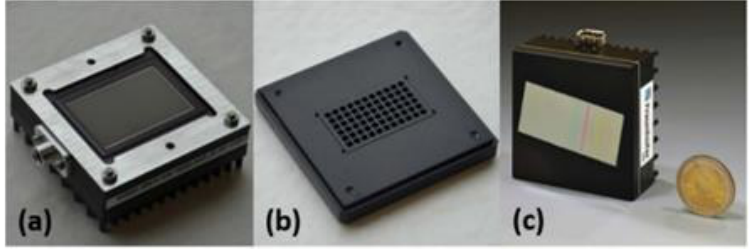
Figure 34. ( a ) Front view of the MSI concept based on a multi-aperture system approach with a slanted LVF. ( b ) Spectral sampling for tilted (red) and non-tilted (blue) orientations of the LVF. The image sensor was a KAI-16000 full-frame CCD, the target surface size was 24 × 36 mm 2 , the pixel size was 7.4 µ m × 7.4 µ m, the resolution was 4872 (H) × 3248 (V), and the number of pixels was 16 M. The image sensor (including mechanical structure), optical isolation array, and system prototype are presented in Figure 35.